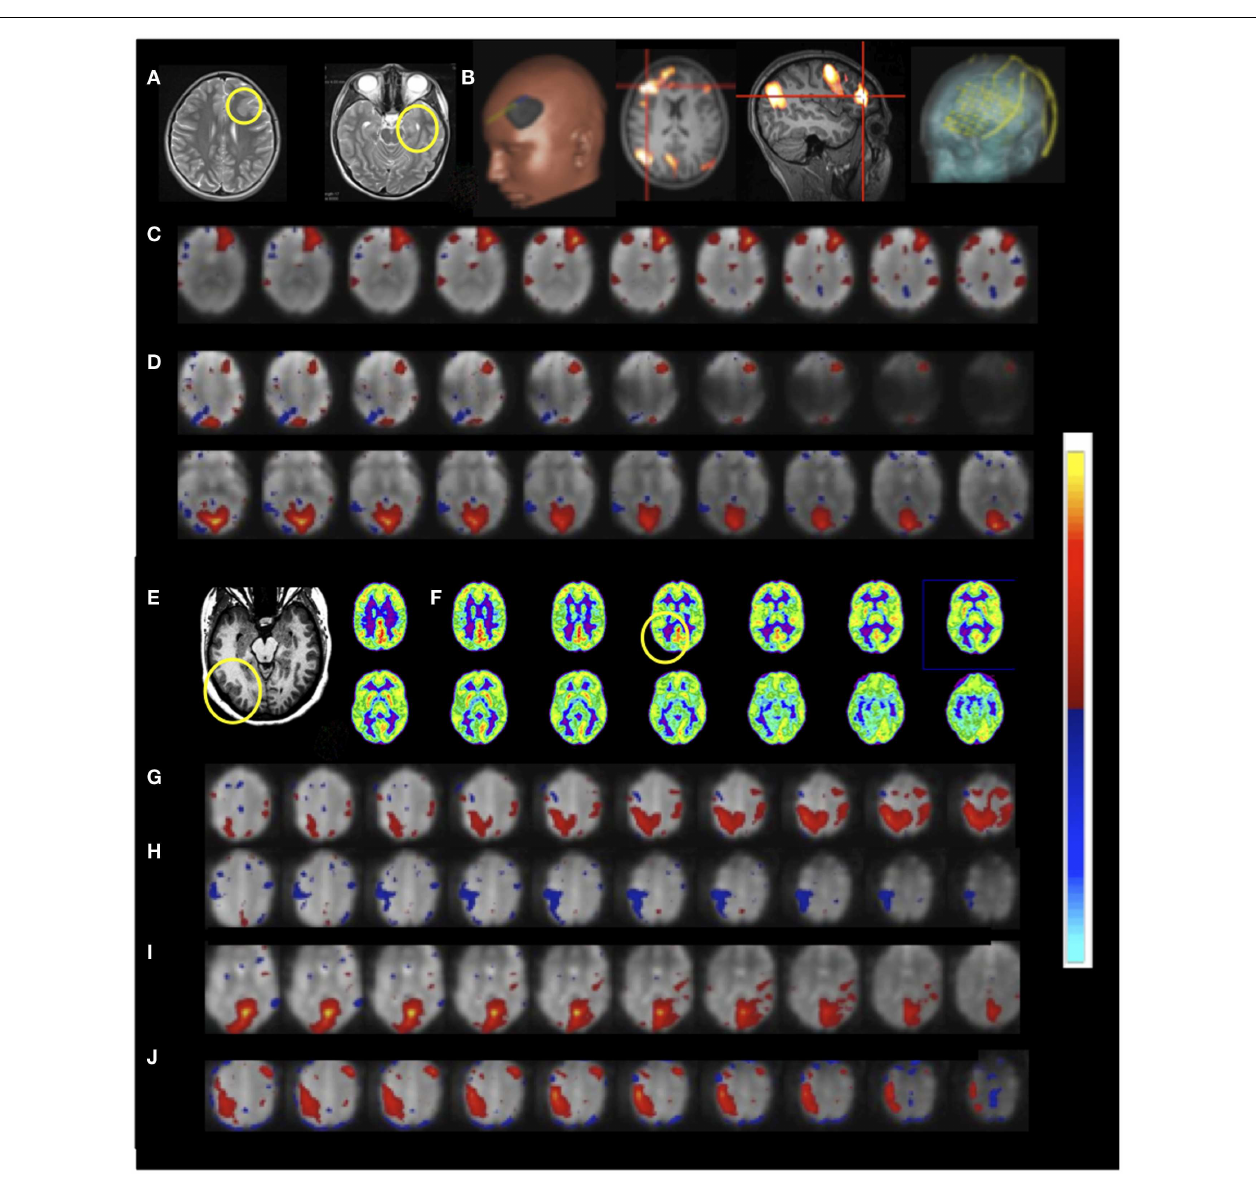
thickening in the right posterior temporal lobe (yellow circle) (F) FDG-PET shows hypometabolism in this region (yellow circle). ICA shows dynamic RSN changes in consecutive scans. (G) An unanticipated RSN emerges in right posterior parietal and temporal cortex during scan 4 ( z max = 15.0). (H,I) In scan 6 the visual RSN displays spatial asymmetry that excludes the right posterior temporal lobe and exhibits negative correlation with the right motor and posterior parietal cortex ( z max = 17.3). (J) The unanticipated RSN in right posterior parietal and temporal cortex extends into inferior regions during scan 8 ( z max = 16.3).The color scale for ICA is shown on the